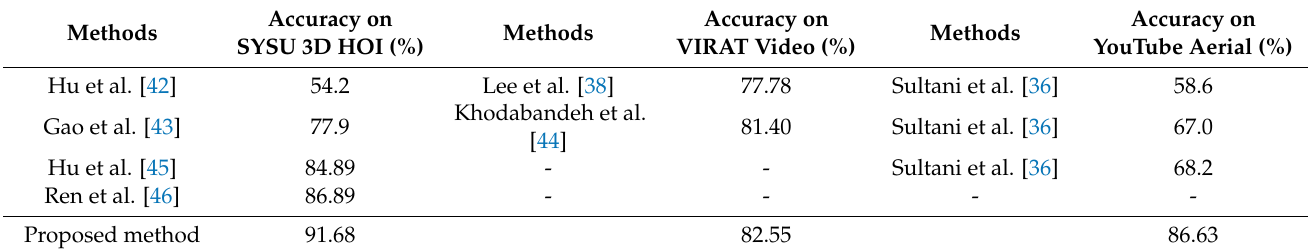
Table 11. Comparison of the state-of-the-art methods with the proposed